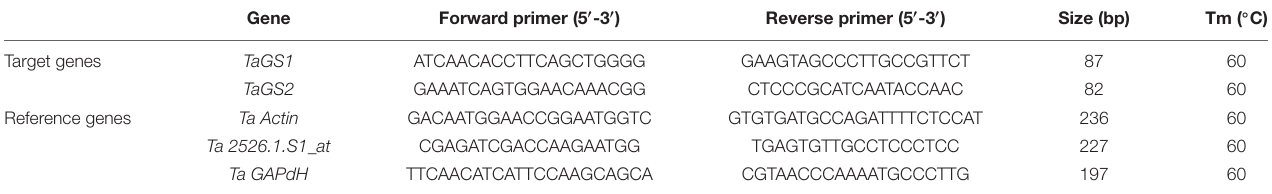
TABLE 2 | Sequences of primers used for qPCR analysis. Gene Forward primer (5 (cid:48) -3 (cid:48) ) Reverse primer (5 (cid:48) -3 (cid:48)